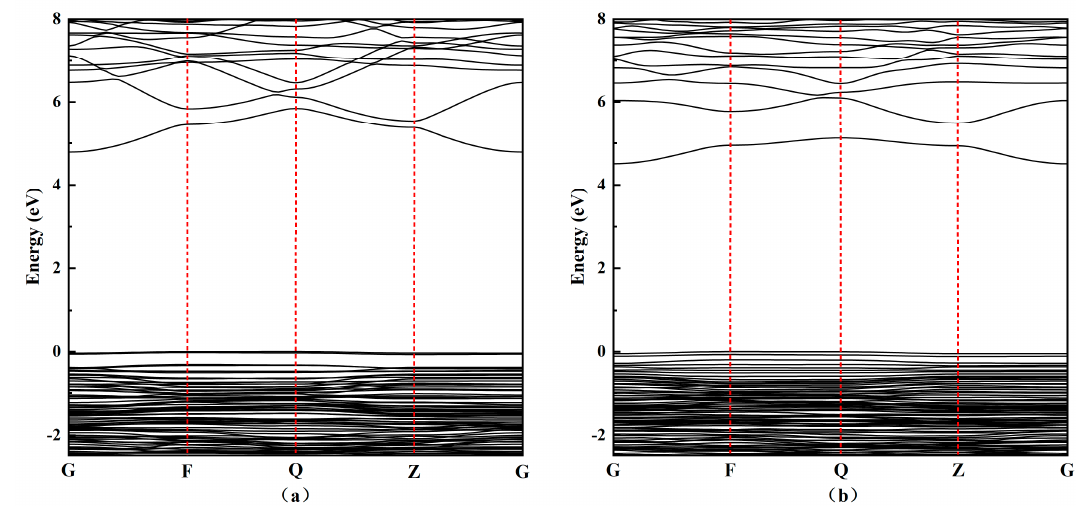
Figure 2. Band structure of the Na-MMT ( a ) and Mg-MMT ( b ) along high-symmetry points in the Brillouin zone at 0 GPa. The Fermi energy was set at zero.